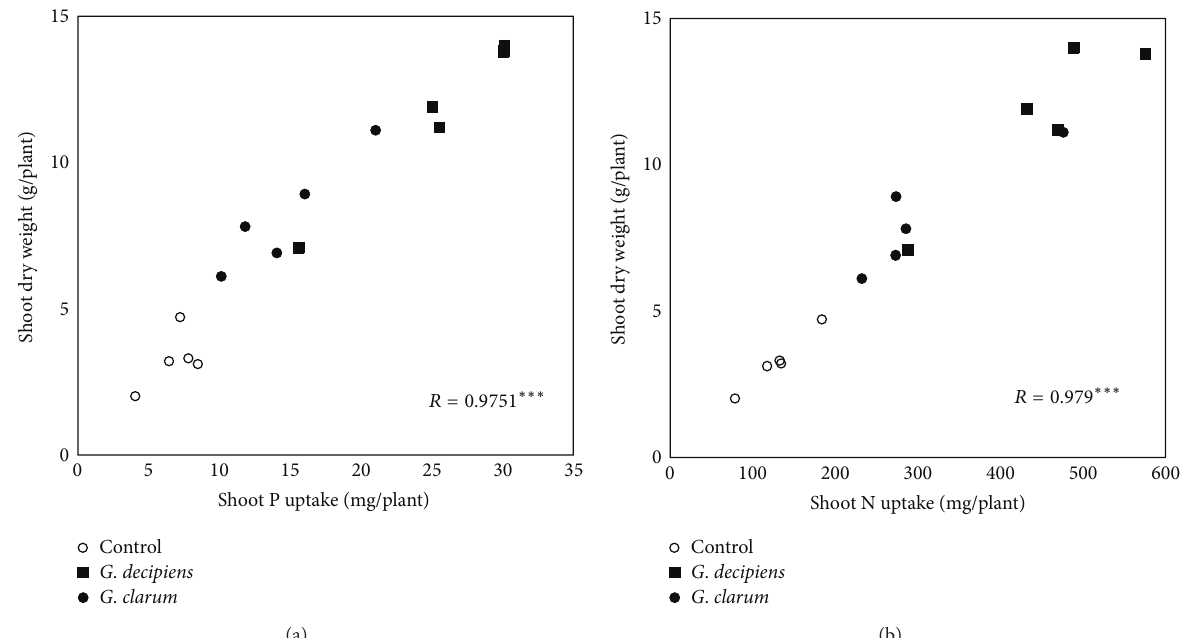
Figure 4: Correlation of shoot P uptake (a) and shoot N uptake (b) with shoot dry weight of A. saman inoculated with AM fungi six months after sowing. Black squares: G. decipiens ; black circles: G. clarum ; white circles: control. ∗∗∗ 𝑃 < 0.001